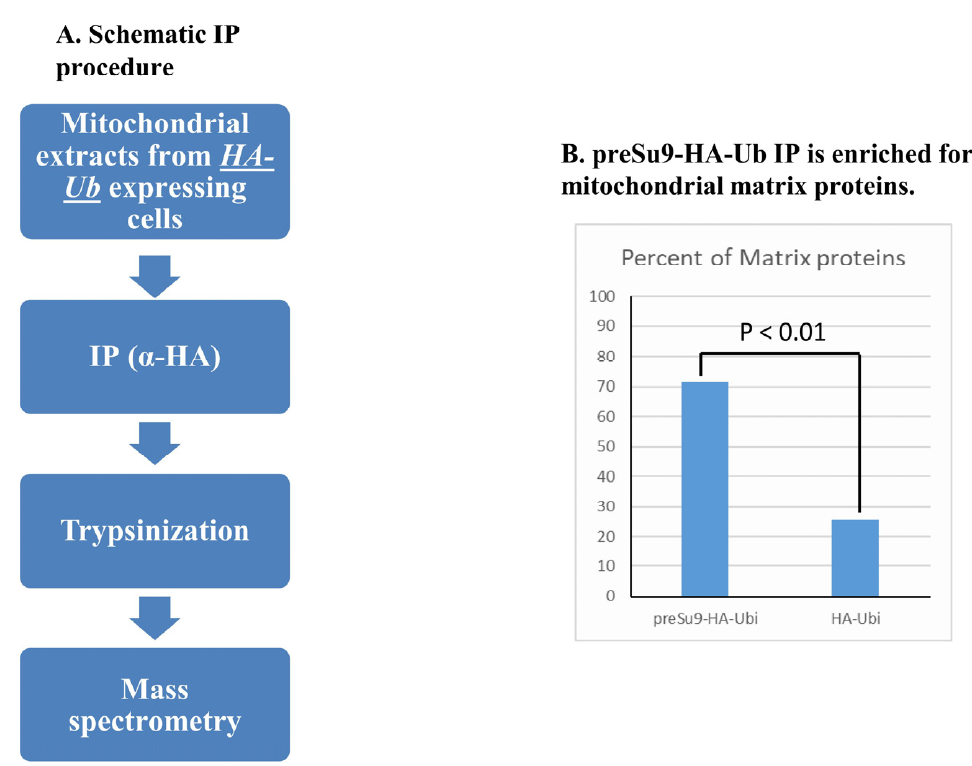
Figure 4. Immunoprecipitation (IP) of ubiquitinated HA containing conjugates. ( A ) Schematic representation of the IP. IPs were performed with anti-HA magnetic beads incubated with mitochondrial lysates of cells harboring empty vector or expressing preSu9-HA-Ub or HA-Ub. IPed samples after trypsinization were subjected to mass spectrometry (MS). ( B ) Percent of matrix proteins detected by MS for preSu9-HA-Ub and HA-Ub IP: 71.6% (78/109) and 25.7% (69/269), respectively. The numerator in each bracket is the number of matrix proteins detected, and the denominator is the number of mitochondrial proteins detected (Table 1). Table 1. IP of preSu9-HA-Ub conjugates is enriched for mitochondrial matrix